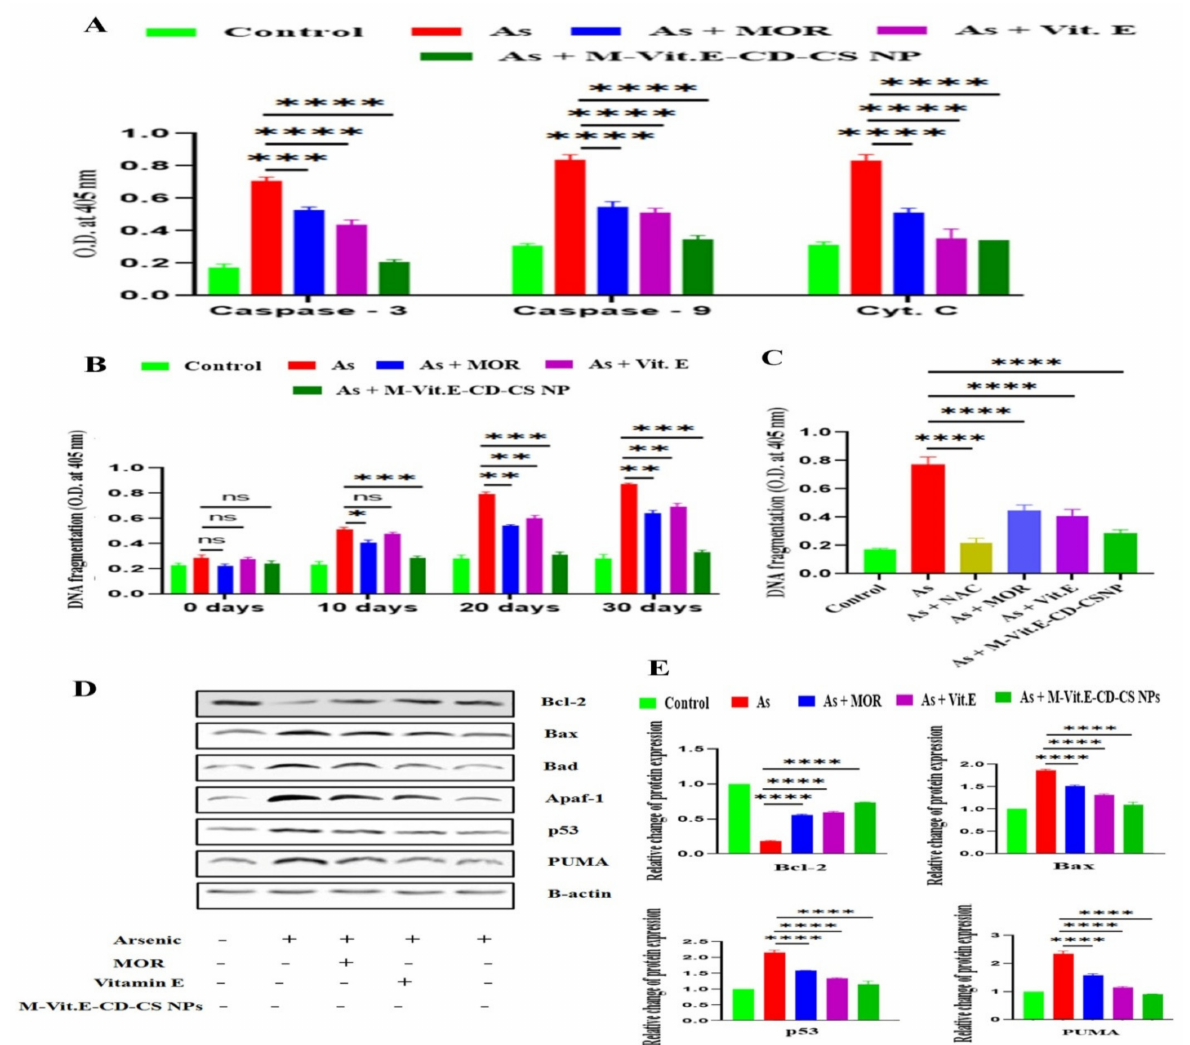
2.7. M-Vit.E-CD-CS NPs Inhibit Apoptosis in Liver Tissue Induced by Arsenic Arsenic-induced inflation of DNA fragmentation, active caspase-3/caspase-9, and cytosolic cytochrome C were conquered by M-Vit.E-CD-CS NPs in the liver tissue lysate (Figure 6A,B). The effect of M-Vit.E-CD-CS NPs on DNA fragmentation was compared with the ROS-inhibitor NAC, which showed that the effect of M-Vit.E-CD-CS NPs was nearly the same as NAC (Figure 6C). In the treated group of mice by arsenic + MOR, arsenic + vitamin E, and arsenic + M-Vit.E-CD-CS NPs, the level of Bax, Bad, p53, Apaf-1, and PUMA were found to be lowered in comparison to their elevated level in the arsenic group. Arsenic exposure suppressed the level of anti-apoptotic protein Bcl-2, which was enhanced by the following treatment of MOR, vitamin E, and M-Vit.E-CD-CS NPs (Figure 6D).